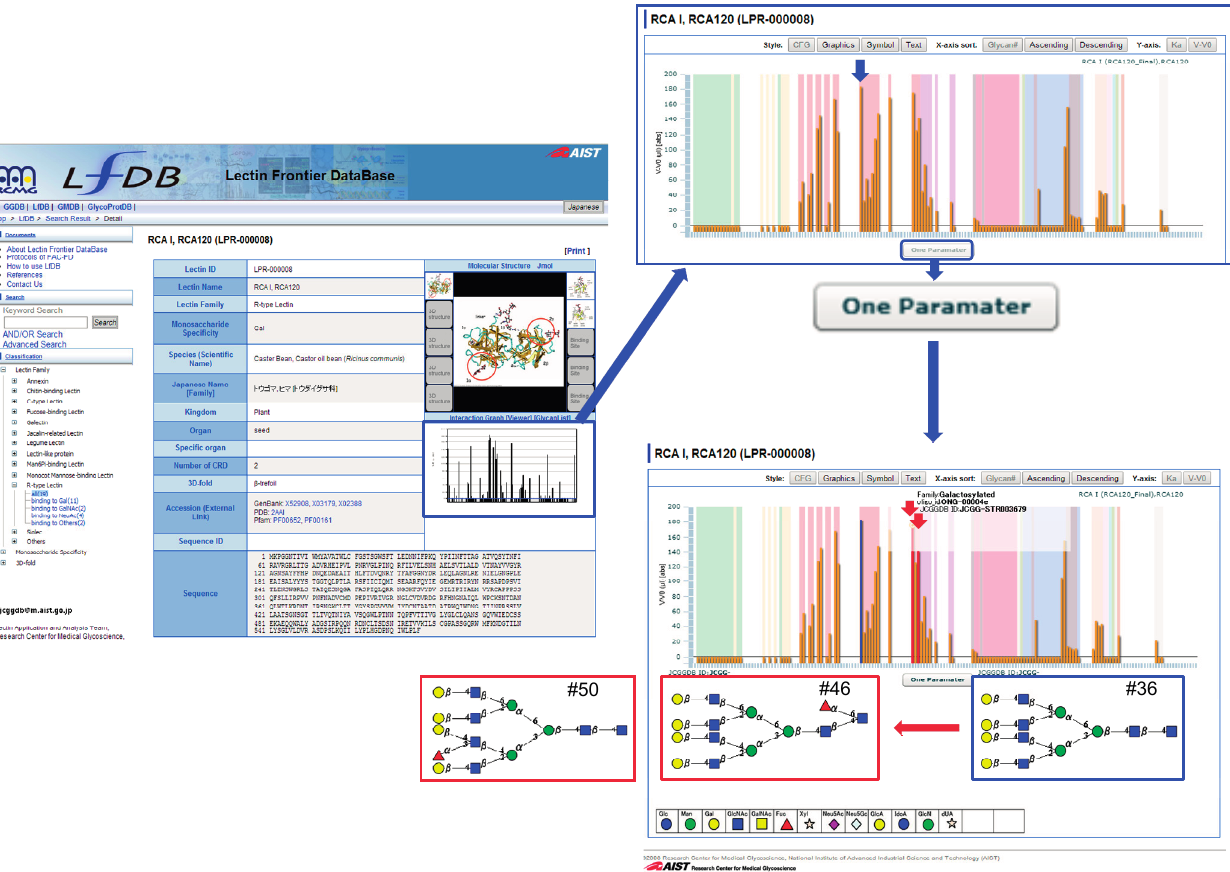
Figure 5. A flow of specificity analysis using “One Parameter” function. Left panel: As an example, RCA I/RCA120 is chosen, which belongs to the R-type lectin. Click the middle-right figure (boxed with blue line) to show the bar graph FAC data. Right panel ( top ): Select a particular oligosaccharide of interest: in this case the one showing the highest affinity (shown with blue short arrow). Click “One Parameter” button to show related but differ regarding one parameter: in this case, two oligosaccharides, #46 and #50 are shown (with red short arrow), which are α 1-6-fucosylated in the reducing terminus and α 1-2-fucosylated in the non-reducing terminus, respectively, relative to the original oligosaccharide